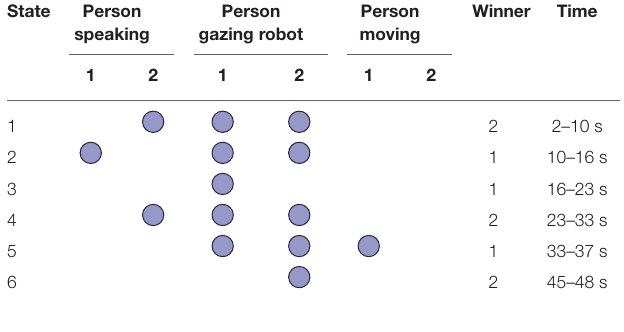
Frontiers in Neurorobotics |